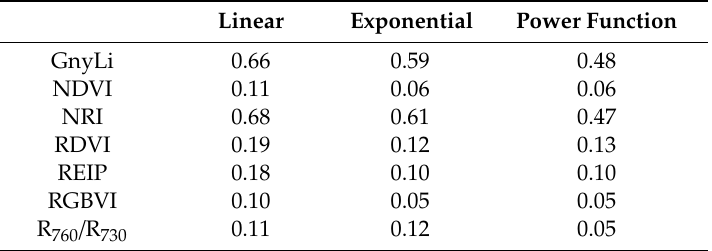
Table 6. Pre-test: Coe ffi cient of determination (R 2 ) between the plot-wise averaged vegetation indices and the nitrogen concentration. Linear Exponential Power Function GnyLi 0.66